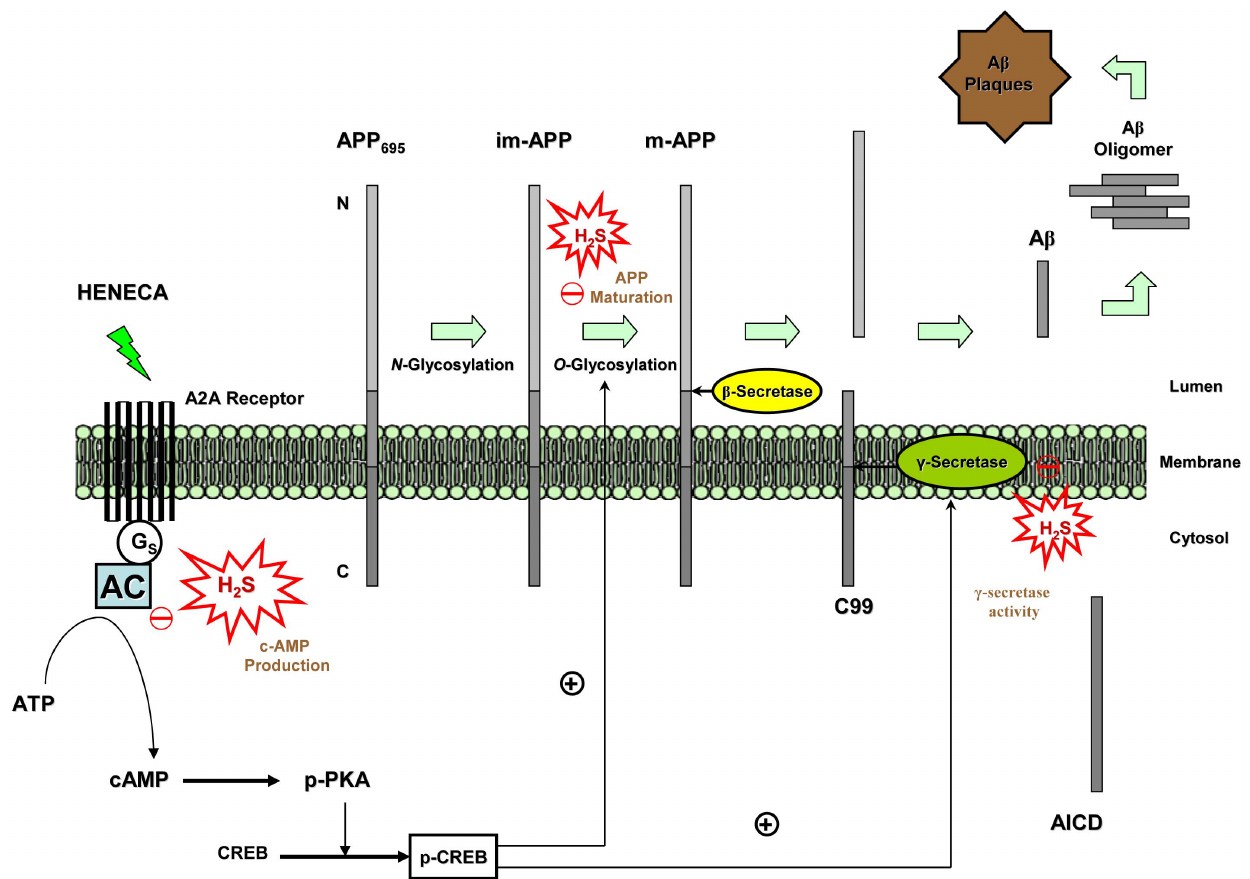
Figure 9. Schematic diagram showing the inhibitory effect of H 2 S on HENECA induced A b generation in SH-SY5Y cells. APP is an integral membrane protein which undergoes post-translational modification such as glycosylation during its transfer through intracellular secretory pathway. The mature isoform of APP (i.e. APP holoprotein) is then acted upon by b - and c -secretases to generate A b . The A2A receptor agonist, HENECA, induces production of A b 42 in SH-SY5Y cells via cAMP/PKA/CREB pathway. It enhances both synthesis and maturation processes of APP increasing total APP production. It also stimulates c -secretase activity in mAPP cleavage resulting in A b generation. H 2 S not only interferes with the step of APP maturation, but also attenuates the production of APP holoprotein. By inhibiting AC (and subsequent cAMP production), H 2 S also inhibits c -secretase activity. It ultimately leads to decreased production in A b .